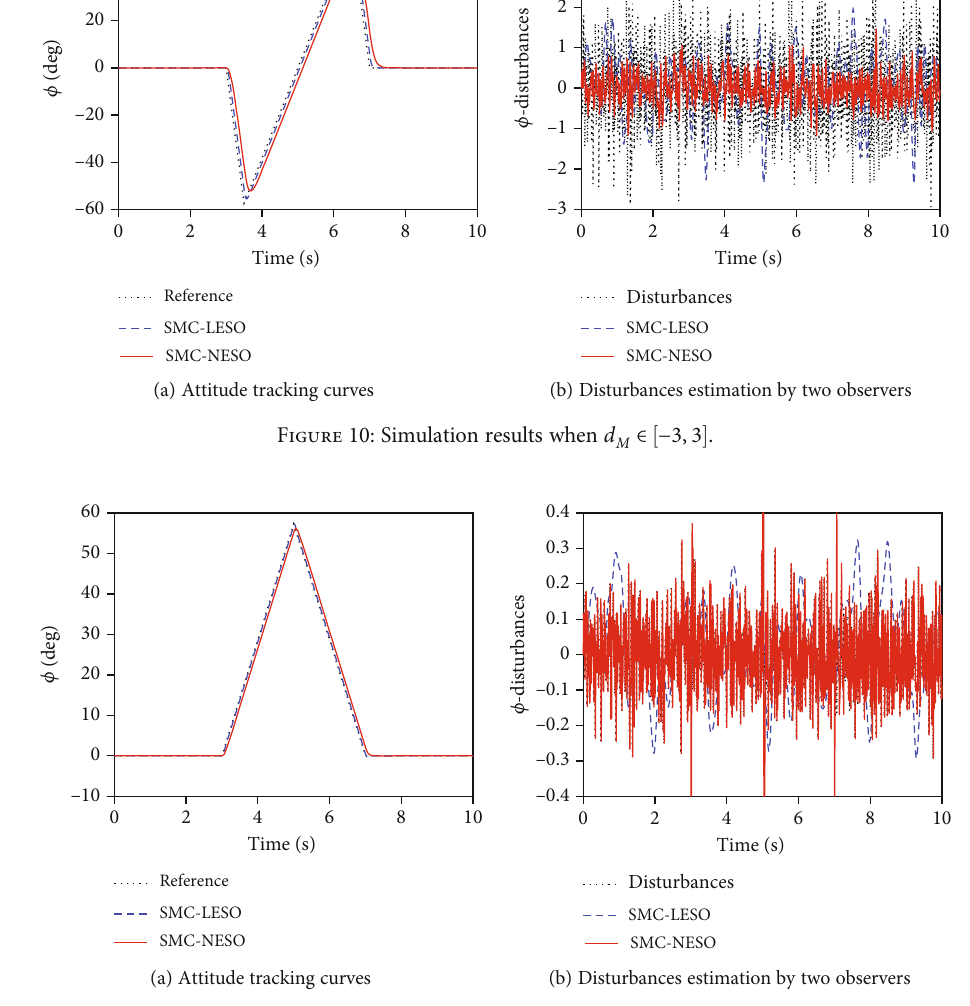
Figure 11: Simulation results when d